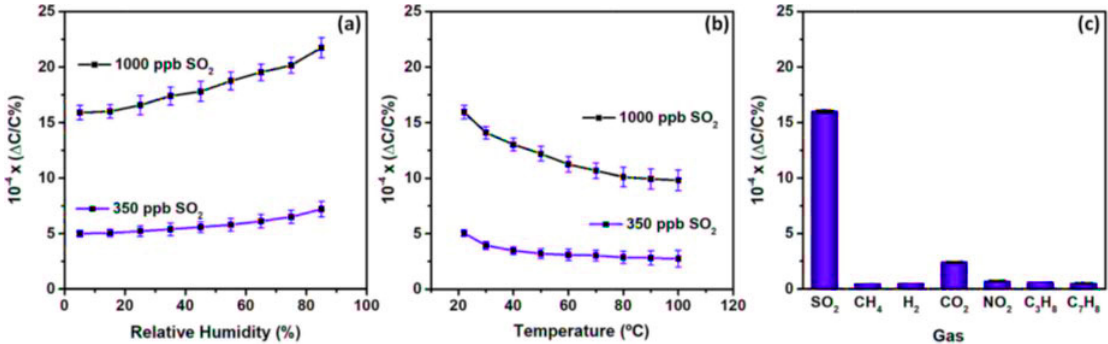
Figure 3. Environment effect of sensing performance with ( a ) relative humidity ( b ) temperature and ( c ) selectivity performance in various gases of MFM-300 (In) MOF sensor. Reproduced and adapted from Ref. [12]; Copyright (2018), RSC Journal of Materials Chemistry A.